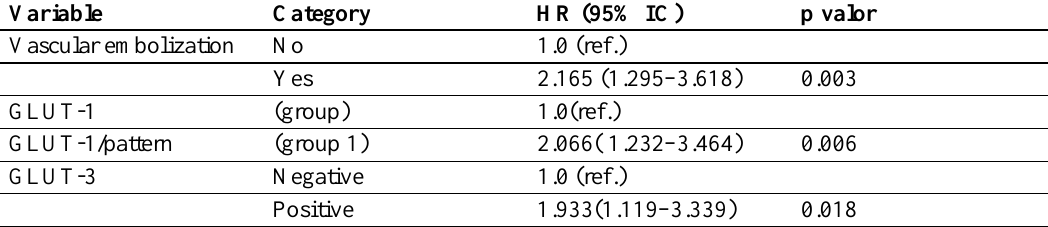
Table 4. Multivariate analysis by Cox regression model: Overall survival.